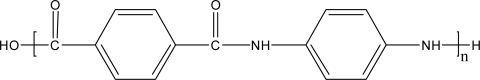
Molecular structure of poly(p-phenylenetetraphthalamide) (PPTA).